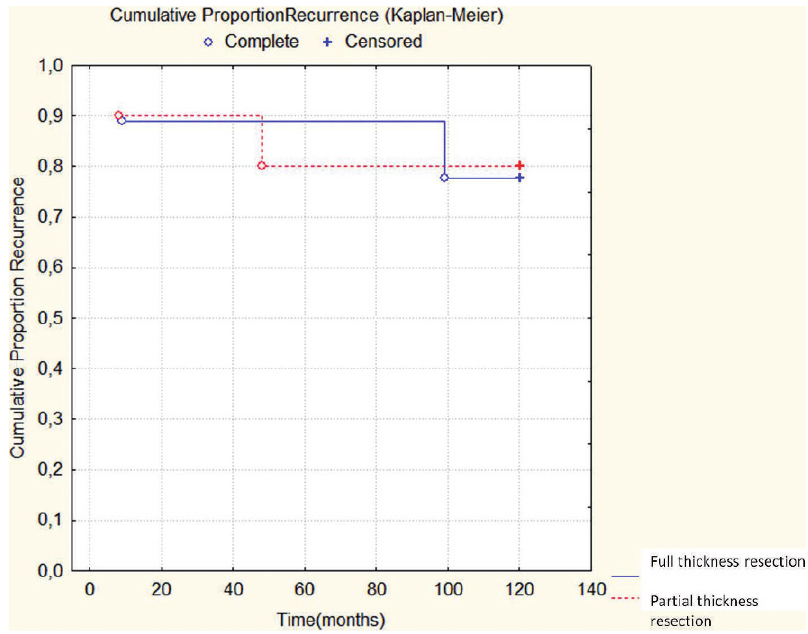
Figure 4 - Cumulative proportion of recurrence events during follow-up (months), depending on the margin status. OR =1.1428 (95% CI, 0.3392